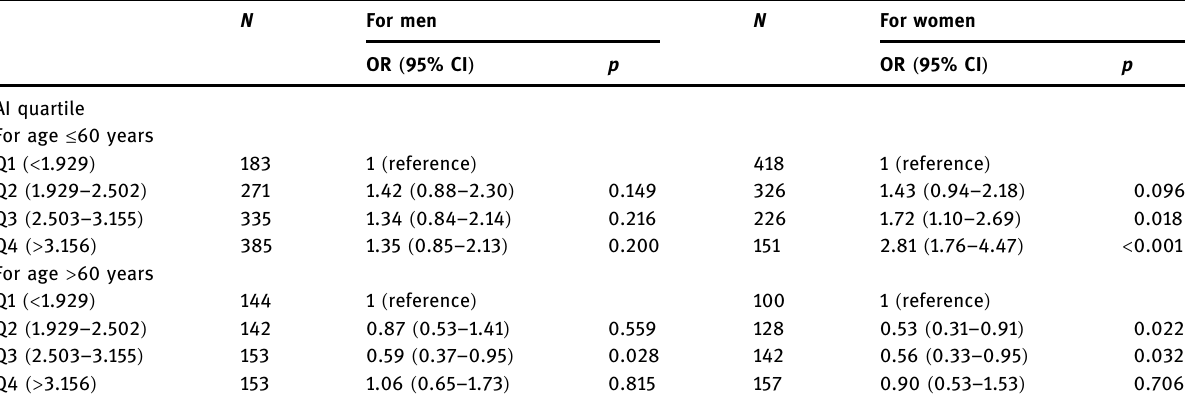
Table 2: OR ( 95% CI ) of hearing loss by AI levels strati fi ed by sex and age N For men N For women